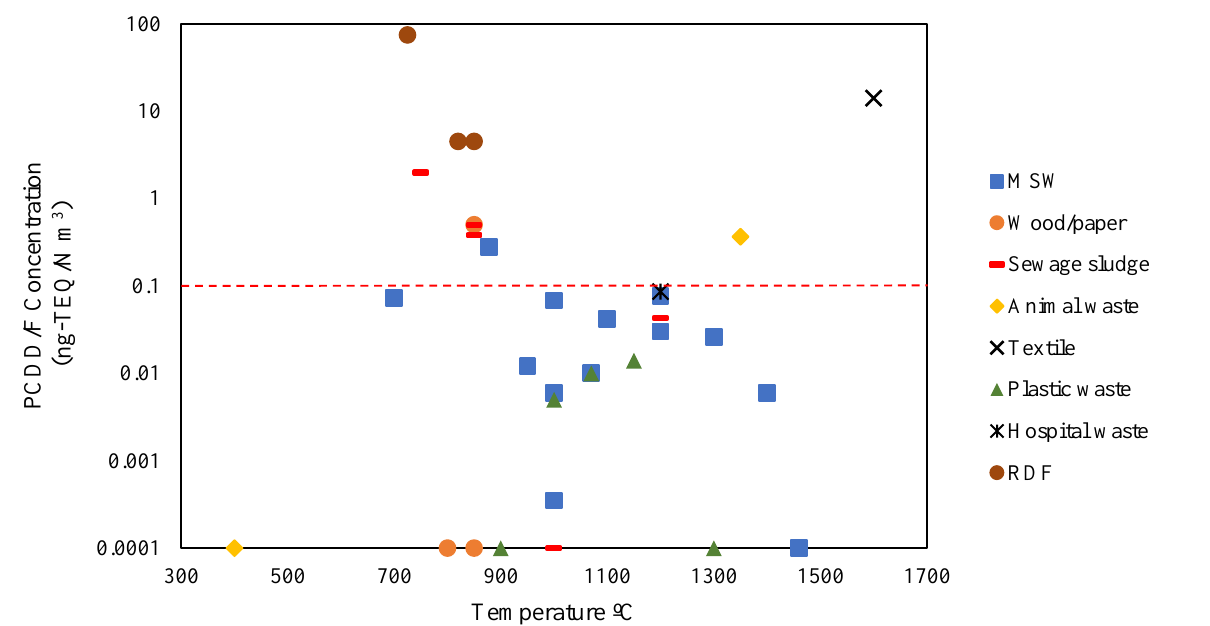
Figure 3. The scatter chart shows the PCDD/Fs concentrations for different feedstock versus temperature. Data points that are Scheme 0 (ng-TEQ/Nm 3 ) are those measurements with dioxin concentration below the detection limit or zero dioxin. As it is not possible to put zero values on a logarithmic axis, the red dashed line is the acceptable limit as determined by national and international organizations (<0.1 ng TEQ/Nm 3 ).